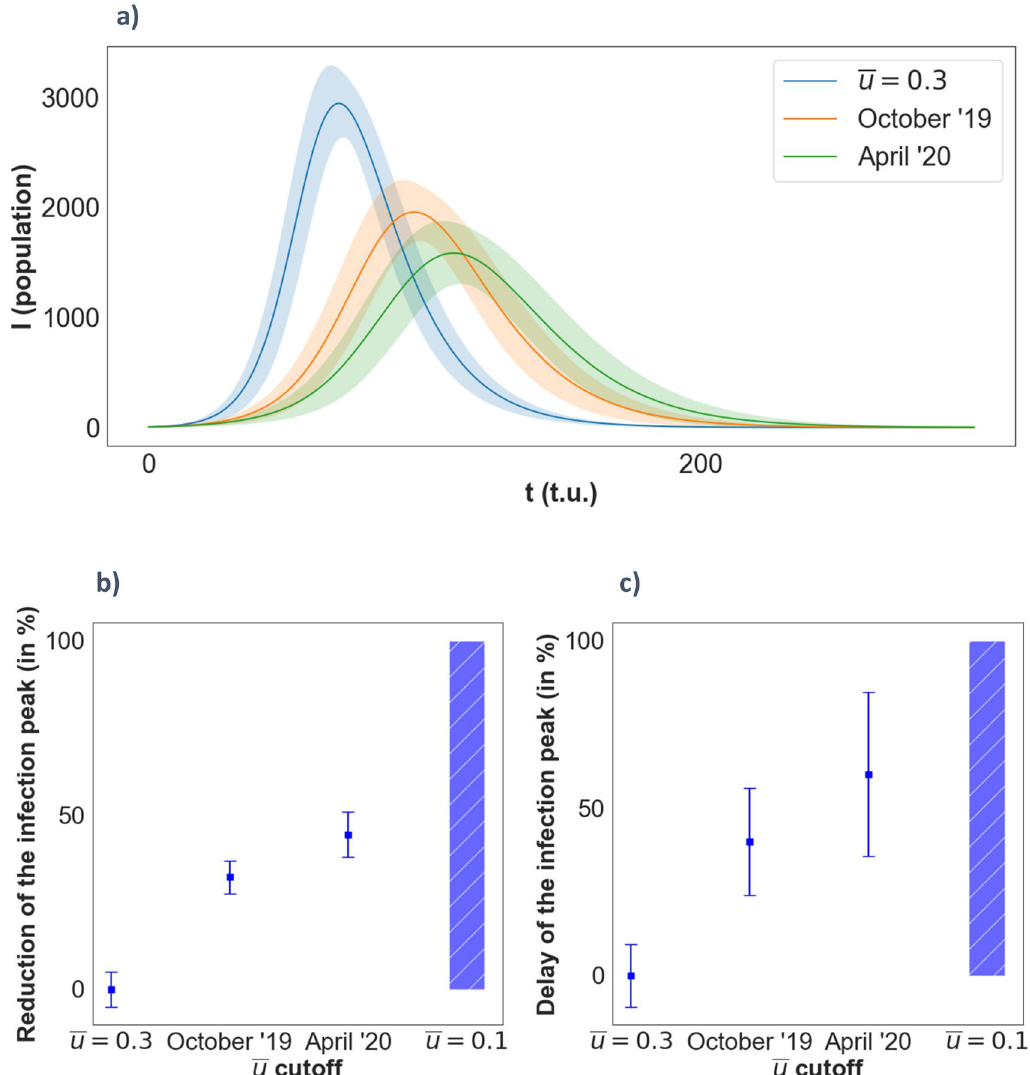
Figure 7. (a) Evolution of the number of infected individuals with time for the three opinion models considered. (b) Reduction in % of the infected individuals on the peak of the curve with respect to the model − u = 0.3 . (c) Time delay in % of the infection peak. Error bars represent the standard deviation with fixed opinion of a sample of peak statistics obtained across several simulations with the same parameters, but different random configurations of the network’s adjacency matrix. ( N = 10, 000, β = 0.05, µ = 0.06, p rewire = 0.25 ) peak (the maximum value found on the infection curve was small but not zero) and the value of the time delay (Fig. 8b) is included in the shaded region since this infection curve was almost flat. Something similar occurs − − u = 0.25 , which explains the large error seen in Fig. 8b. Note that this value of the cutoff, u = 0.2 , for the cutoff in constitutes by itself an actual threshold bellow which no infection peak is observed. As discussed in the previous section, we are considering a Watts-Strogatz model for the mobility network. This type of network is characterized by a probability of rewiring (as introduced in the previous section) that stablishes the number of distant connections for each individual in the network. All previous results were obtained con- sidering a probability of rewiring of 0.25. Figure 9 shows the variation of the maximum for the infection curve and time for the maximum versus this parameter. The observed trend indicates that the higher the clustering (thus, the lower the probability of rewiring) the more difficult is for the disease to spread along the network. This result is supported by previous studies in the field, which show that clustering decreases the size of the epidem- ics and in cases of extremely high clustering, it can die out within the clusters of population 31,34 . This can be understood in terms of the average shortest path of the network 21 , which is a measure of the network topology that tells the average minimum number of steps required to travel between any two nodes of the network. Start- ing from the ring topology, where only the nearest neighbors are connected, the average shortest path between any two opposite nodes is dramatically reduced with the random rewiring. Remember that these new links can be understood as short-cuts or long-distance connections within the network. Since the infection process can